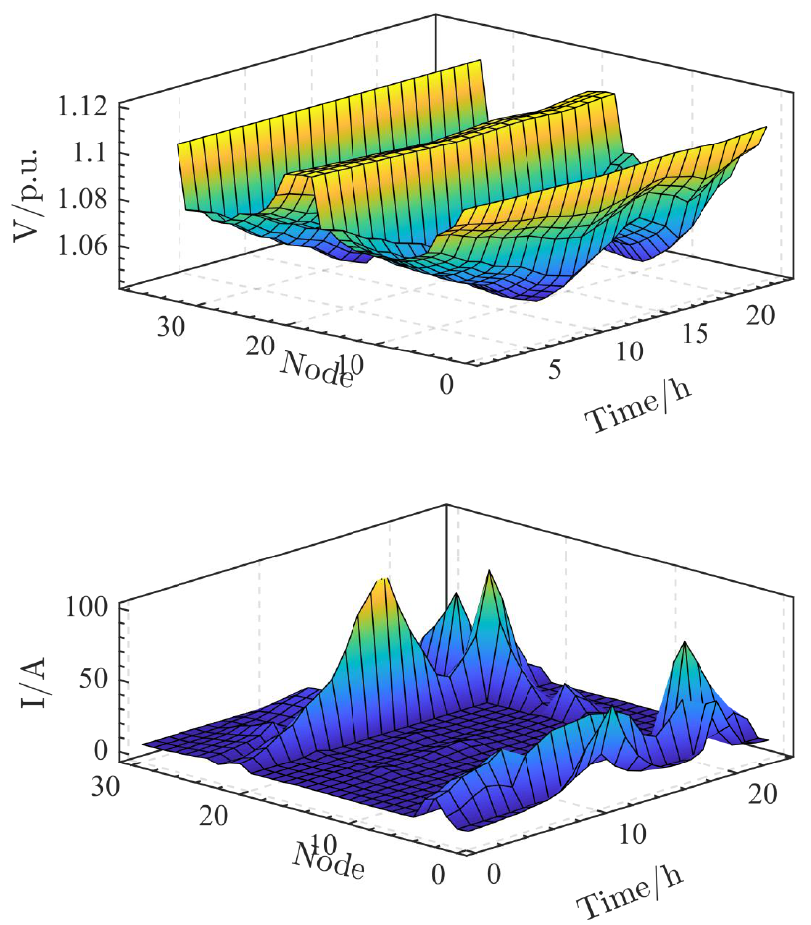
Figure 8. System node voltage and current before scheduling.